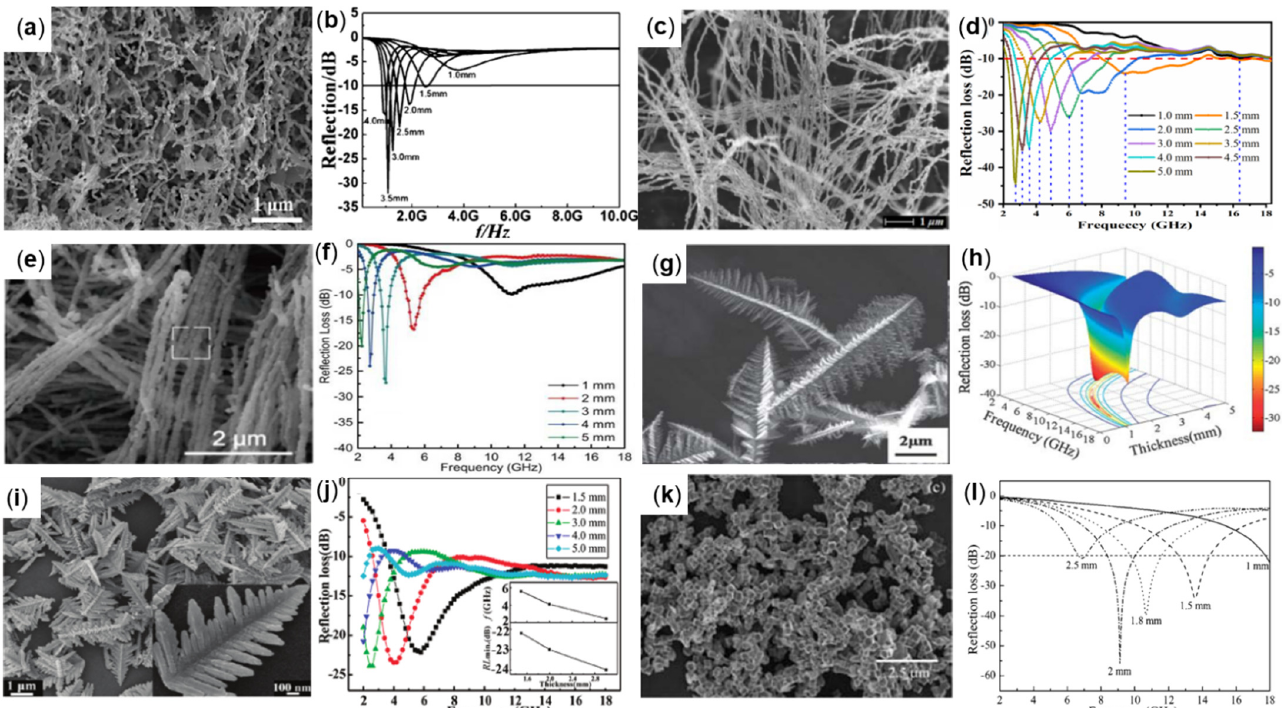
Figure 6. ( a ) SEM and ( b ) RL plot of Fe nanowires, reproduced with permission from Ref. [55], Copyright 2014, Elsevier. ( c ) SEM and ( d ) RL plot of Fe NWs, reproduced with permission from Ref. [56], Copyright 2020, IOP Publishing. ( e ) SEM and ( f ) RL plot of chain-like Fe NWs, reproduced with permission from Ref. [57], Copyright 2016, The Royal Society of Chemistry. ( g ) SEM and ( h ) RL plot of chain-like Fe NWs, reproduced with permission from Ref. [58], Copyright 2013, The Royal Society of Chemistry. ( i ) SEM and ( j ) RL plot of dendrite-like α -Fe 2 O 3 , reproduced with permission from Ref. [59], Copyright 2011, American Chemical Society. ( k ) SEM and ( l ) RL plot of cube shape-like Fe, reproduced with permission from Ref. [60], Copyright 2010, The Royal Society of Chemistry.